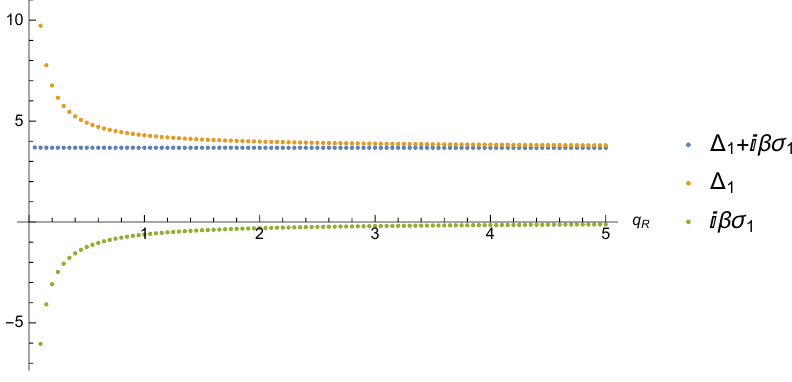
Figure 4 . Numerical values of ˆ∆ 1 , i ˆ β ˆ σ 1 and the combination ˆ∆ 1 + i ˆ β ˆ σ 1 for Case 1 as a function of q R .